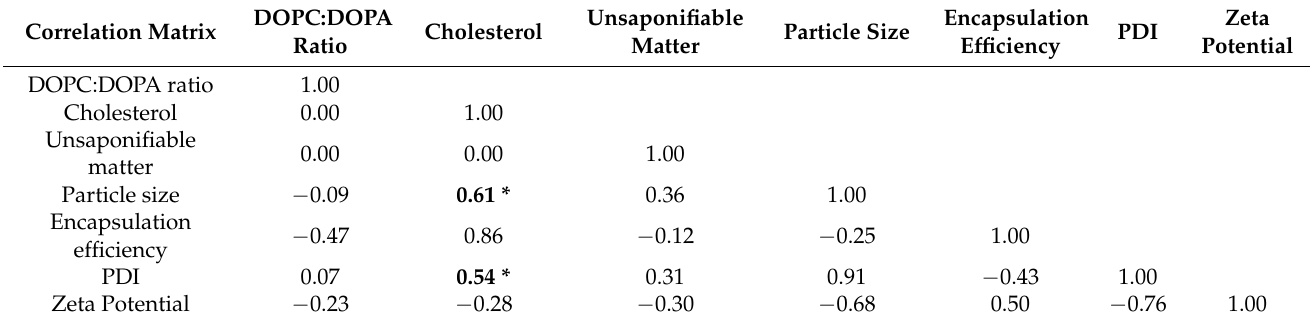
Table 3. Correlation coefficients between variables.